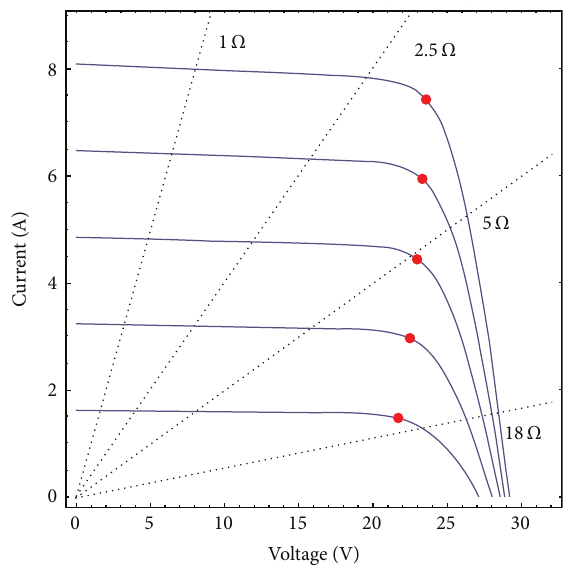
Figure 1: Working point of a generic PV panel at constant temper- ature (25 ∘ C) varying insolation and electric load.